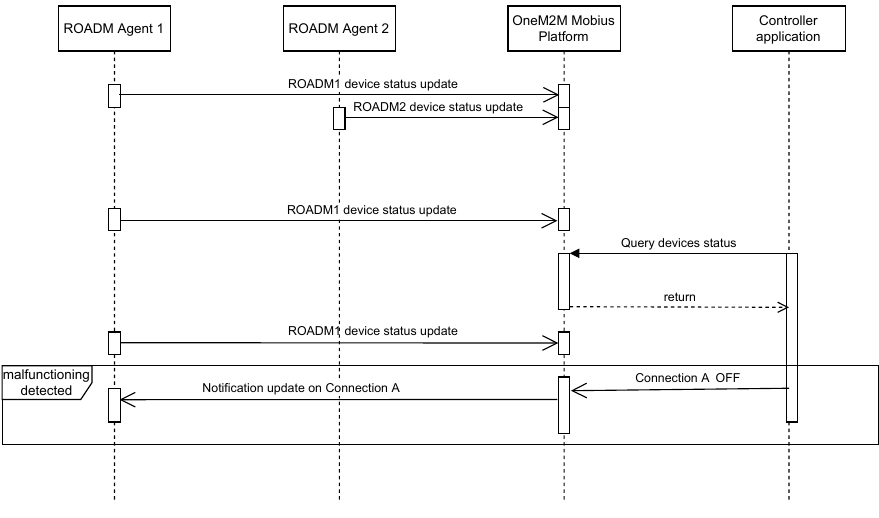
Figure 6. UML sequence schema of the interactions between the network